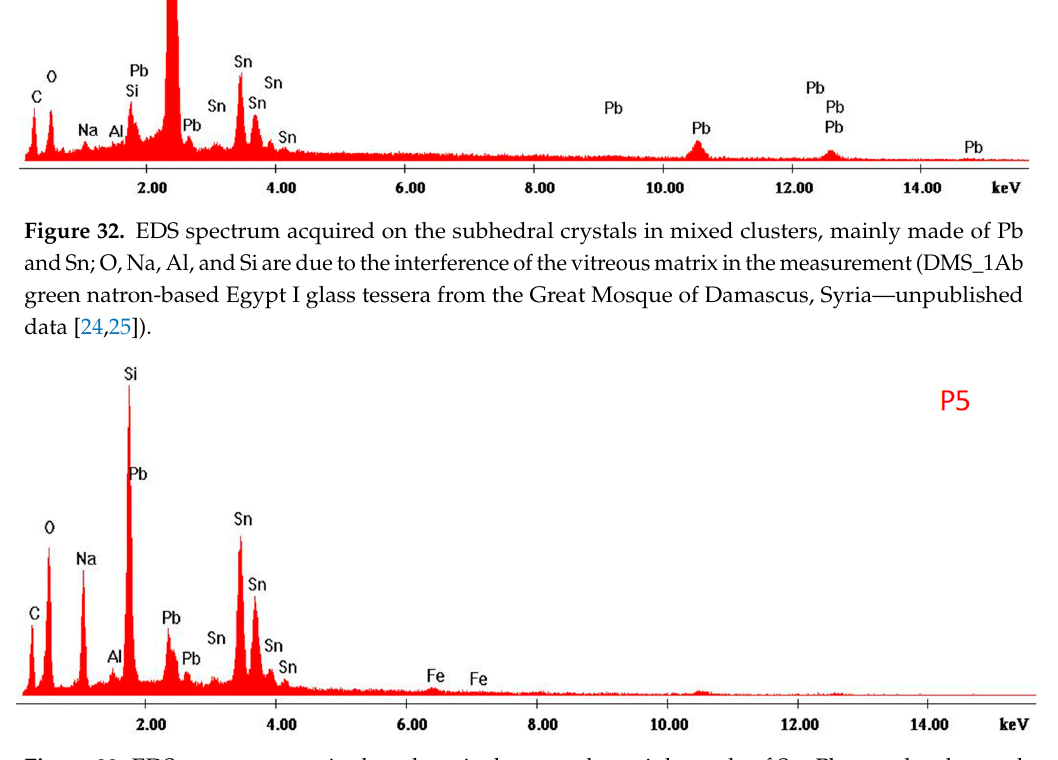
Figure 33. EDS spectrum acquired on the acicular crystals, mainly made of Sn. Pb was also detected in lower amount as compared to the subhedral crystals; O, Na, Al, Si, and Fe were due to the interference of the vitreous matrix in the measurement (DMS_1Ab green natron-based Egypt I glass tessera from the Great Mosque of Damascus, Syria—unpublished data [24,25]).